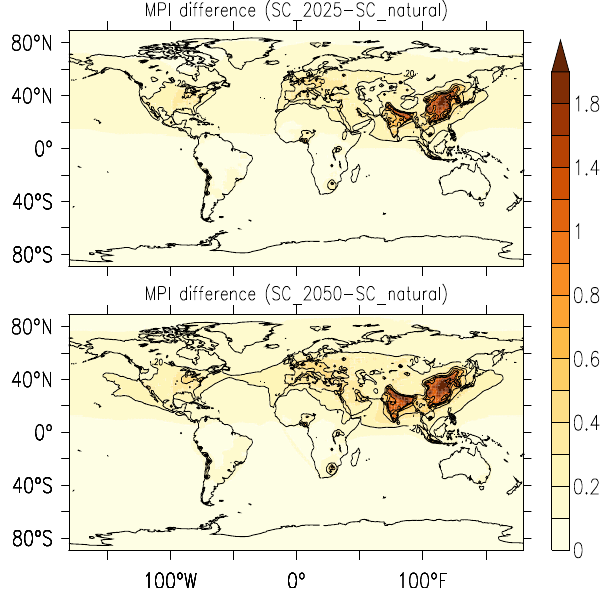
Fig. 11. Difference between the MPI estimated from simulations SC 2025 and SC 2050 and the MPI calculated from simulation SC natural . The contours are shown at multiples of 0.2 up to the level of